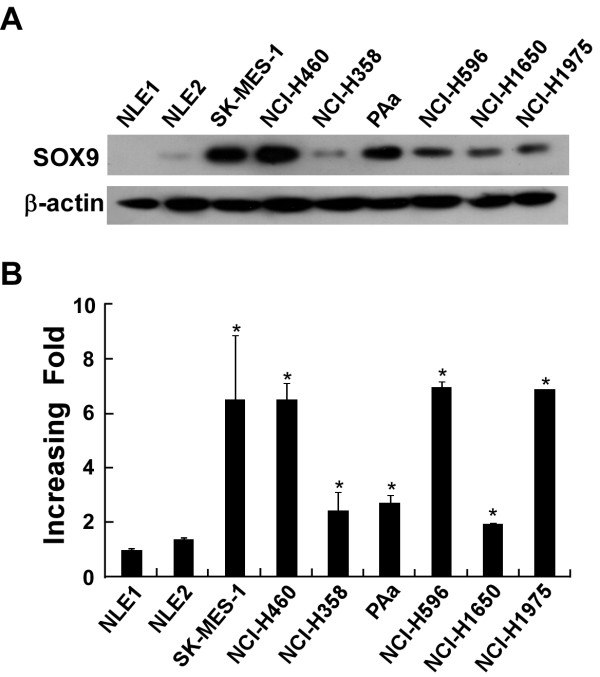
Expression of SOX9 was elevated in NSCLC cell lines. A and B. Expression analysis of SOX9 protein and mRNA in normal human pneumonocyte (NLE) and NSCLC cell lines (SK-MES-1, NCI-H460, NCI-H358, PAa, NCI-H596, NCI-H1650, NCI-H1975) by Western blotting (A) and real-time RT-PCR (B). Protein expression levels were normalized with β-actin mRNA expression levels were normalized for GAPDH. Bars, SD from three independent experiments.